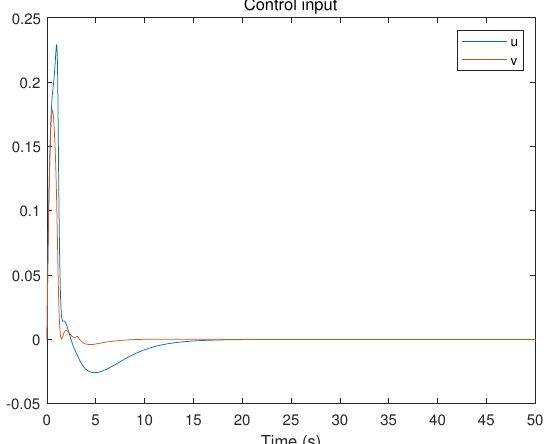
Figure 13. Control trajectories for two players when η 1 = − 0.2 and η 2 = 0.2.